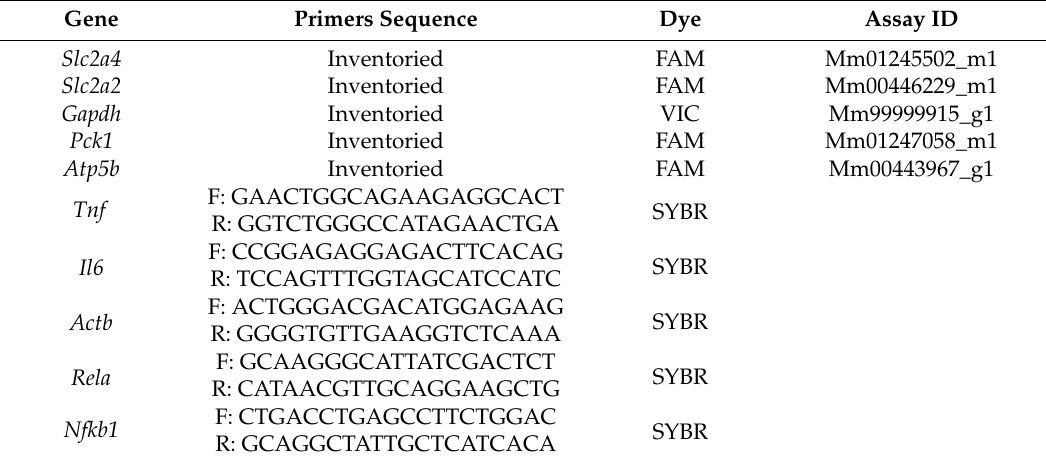
Table 2. Details of the Taqman ® and SYBR ® gene expression assays used for real-time polymerase chain reaction